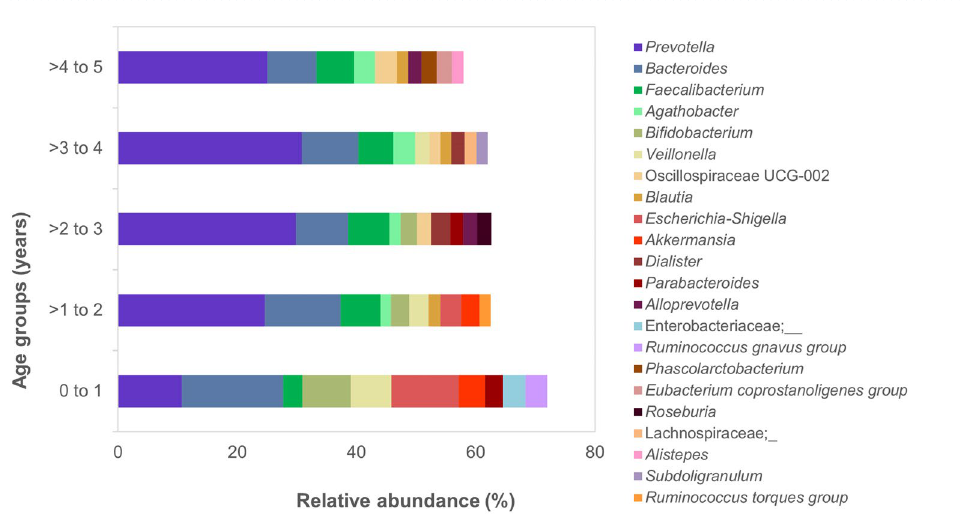
Figure 2. The relative abundance of the top ten genera in each of the five age